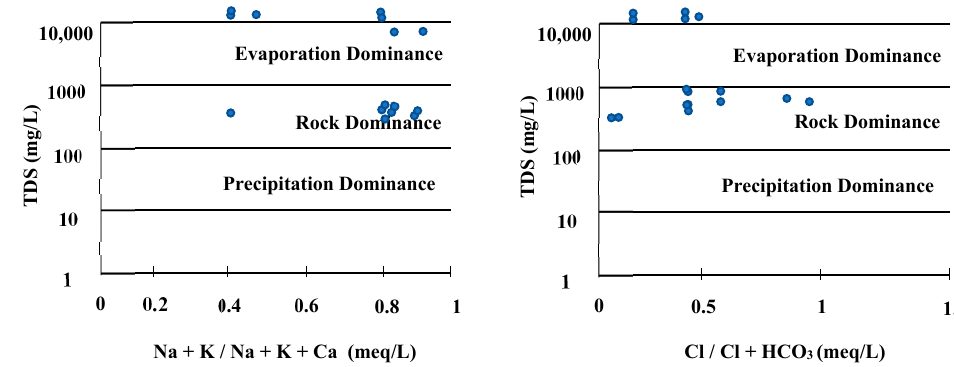
Figure 8. Gibbs diagram for groundwater classification in the study area.